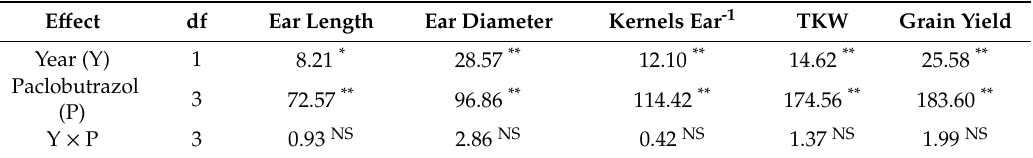
Table 1. Results of ANOVA on the e ff ects of the year (Y) and paclobutrazol (P) on the ear size, grain yield, and yield components of